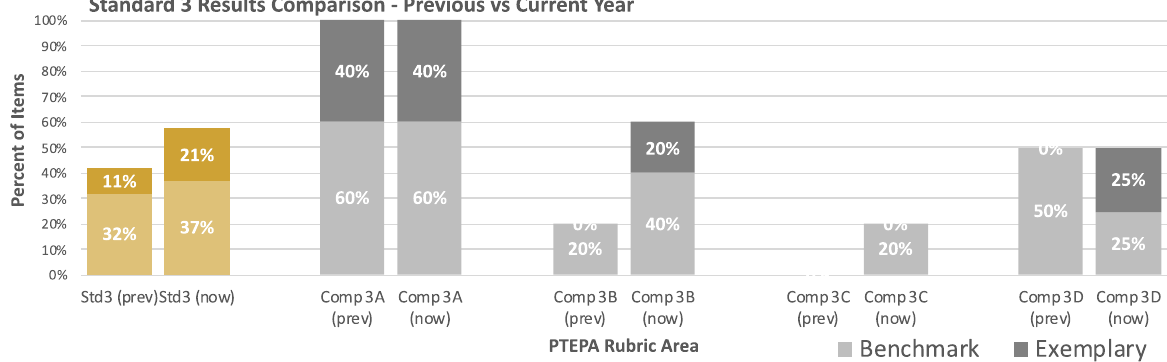
FIG. 5. Comparing PTEPA rubric results for the previous year to the current year for standard 3. The percent of items at the benchmark and exemplary level are